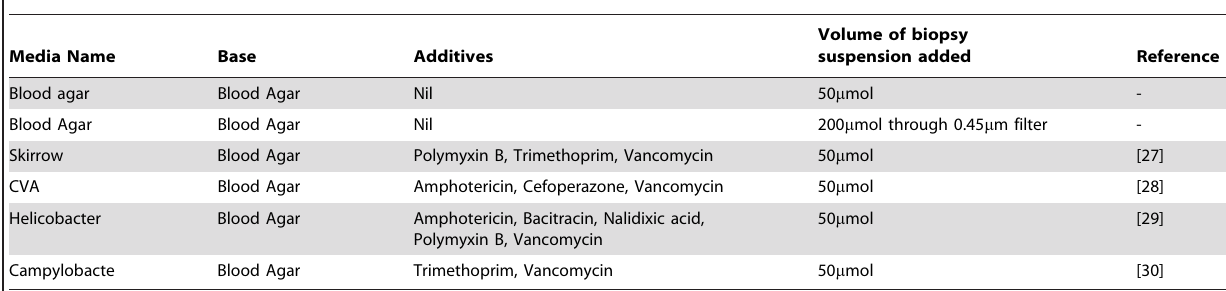
Table 1. Culture media used in the study.